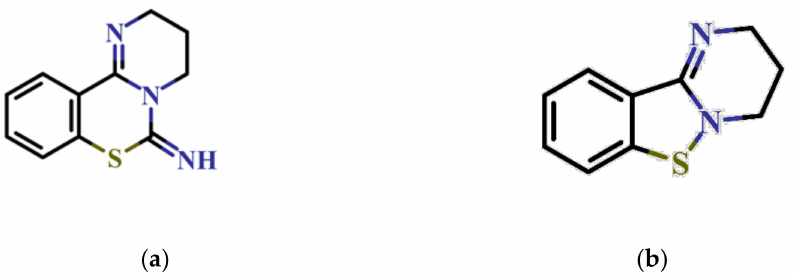
Figure 1. Structures of 3,4-dihydro-2 H ,6 H -pyrimido[1,2- c ][1,3]benzothiazin-6-imine ( a ) and 3,4- dihydro-2 H -benzo[4,5]isothiazolo[2,3- a ]pyrimidine ( b